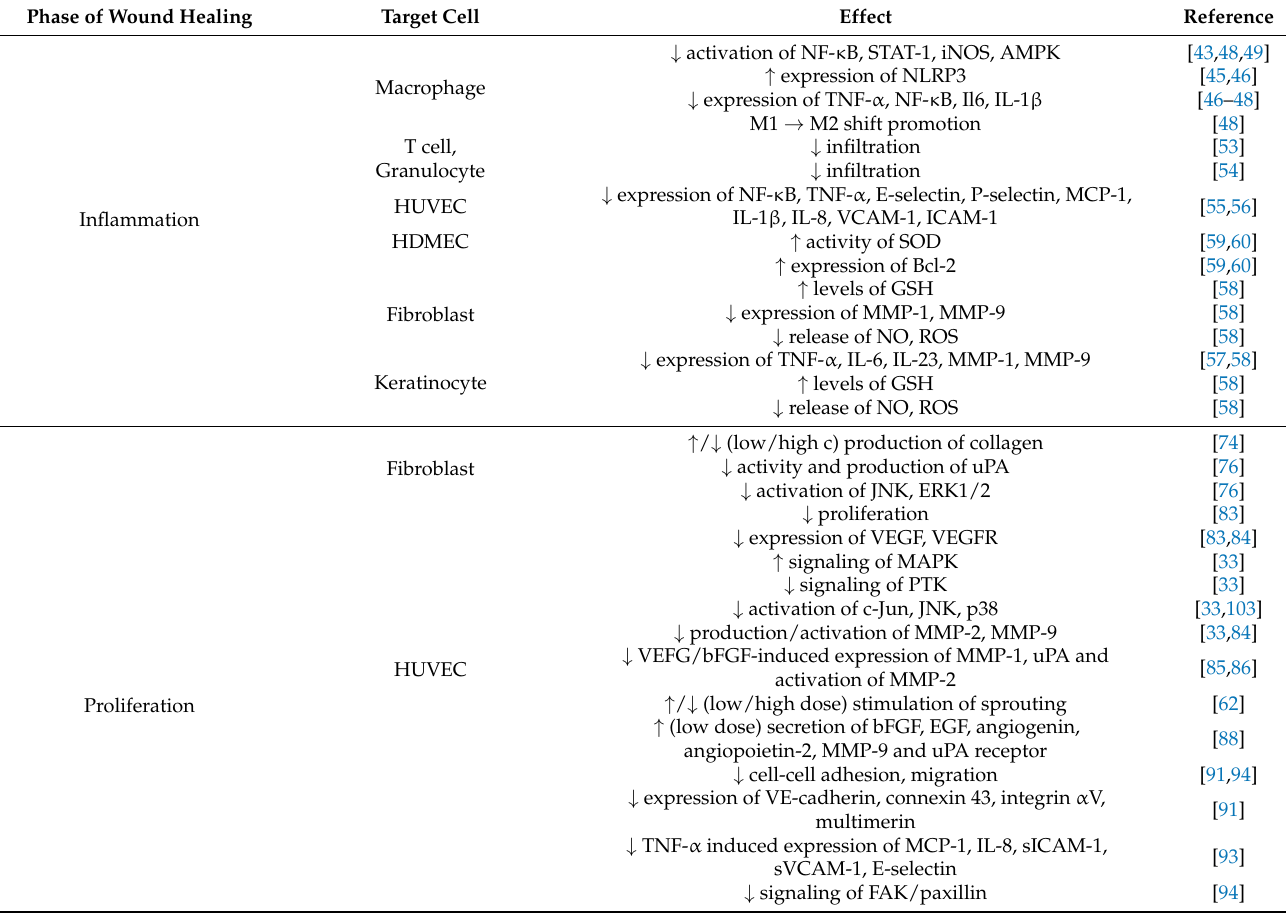
Table 1. Genistein activity on wound